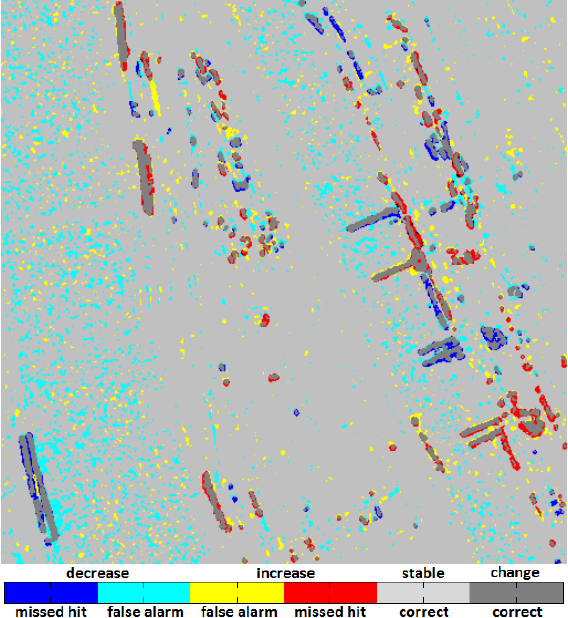
Figure 18. Location of the confusion matrix elements for the change in amplitude using pixel-based